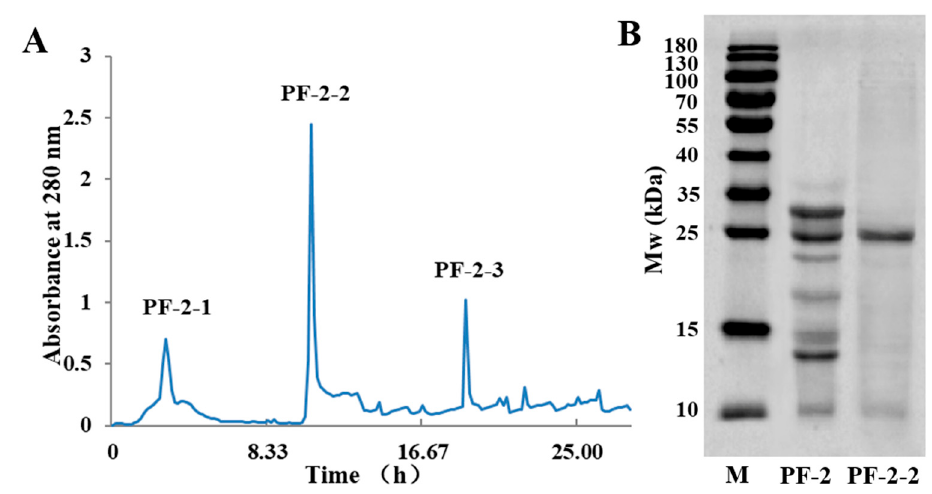
Figure 5. Sephadex G-75 chromatographic diagram ( A ) and SDS-PAGE analysis of PF-2-2 ( B ). M: Protein Markers.